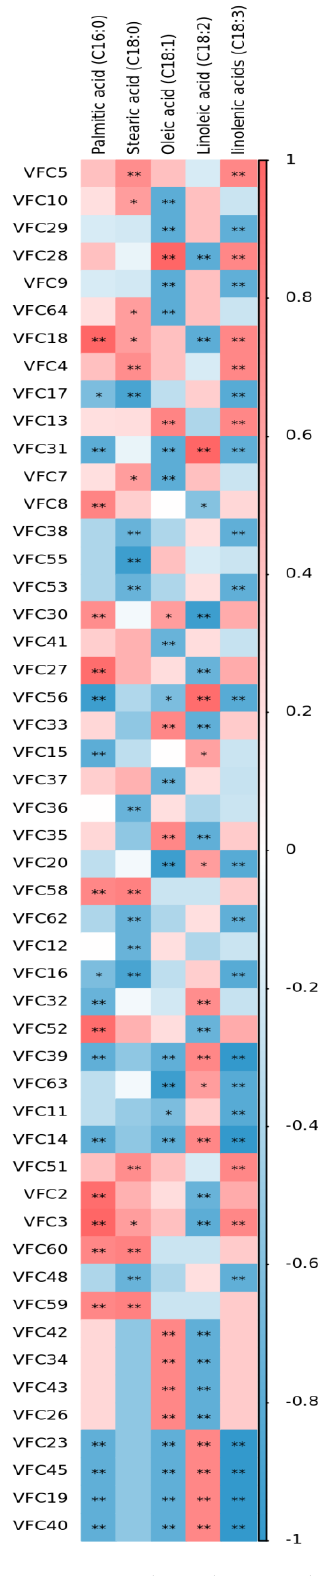
Figure 4. Correlation heat map between fatty acids and flavor substances in pretreated oat bran. Red represents positive correlation, blue represents negative correlation, * represents p < 0.05, ** represents p < 0.01.